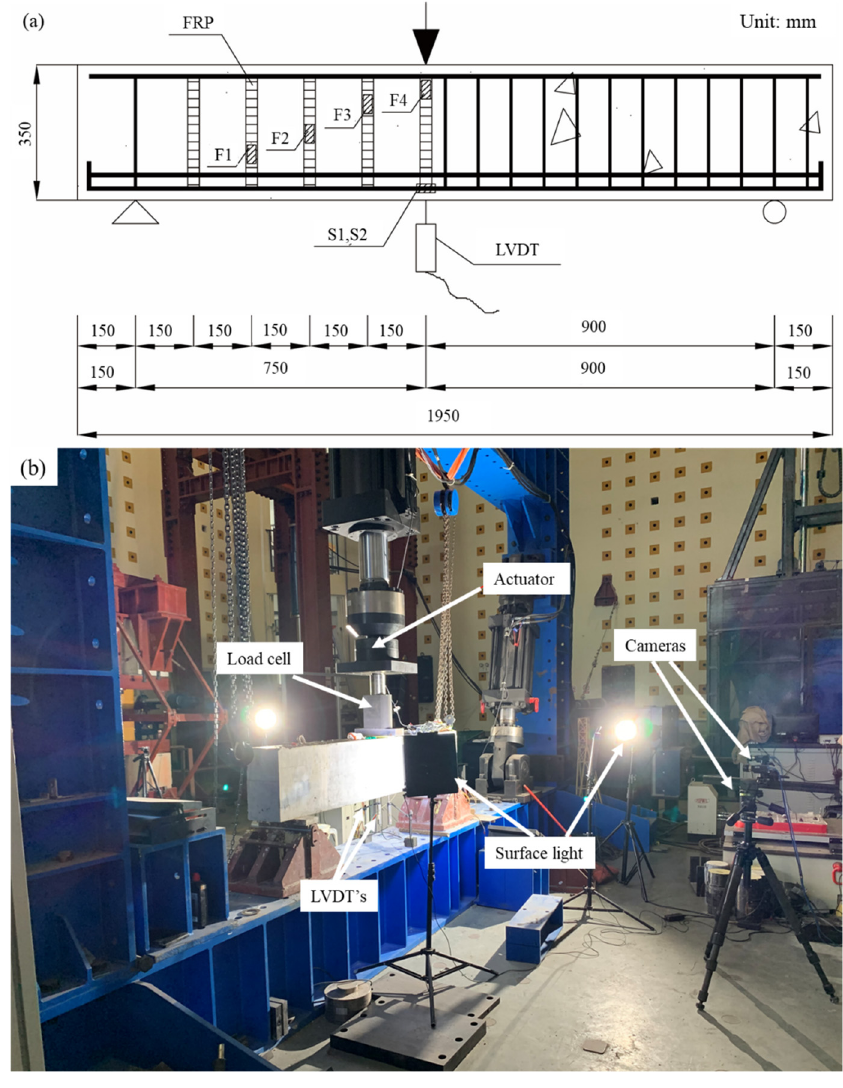
Figure 5. Instrumentation: ( a ) strain gauges and LVDT; and ( b ) DIC system.